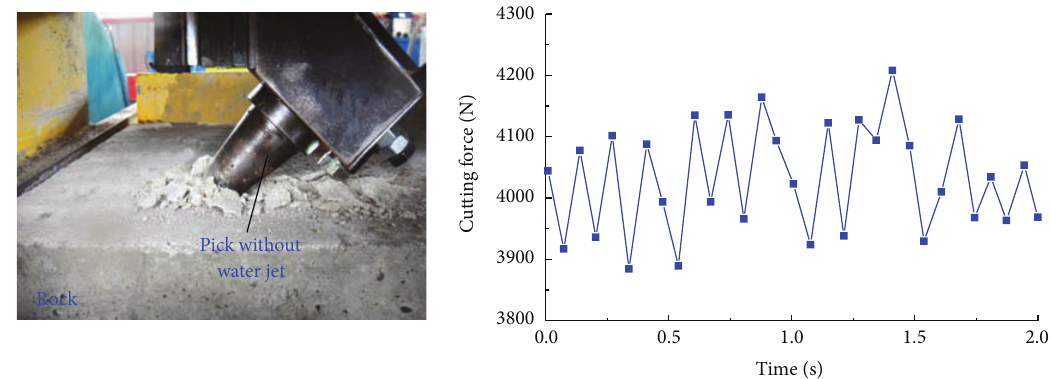
Figure 6: Photo of cutting experiment and cutting force for pick without water jet.